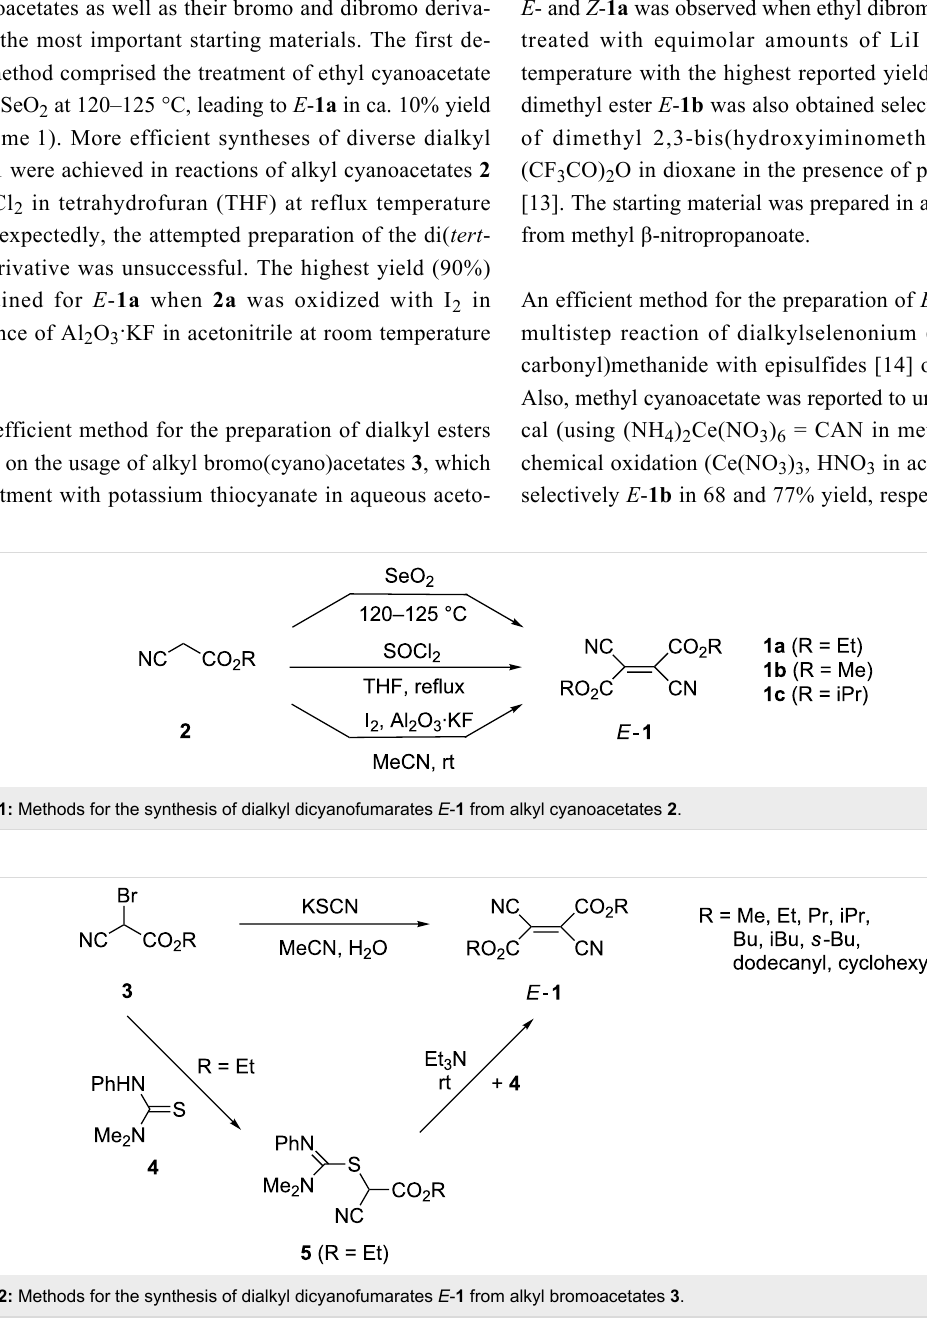
Synthesis of dialkyl dicyanofumarates and